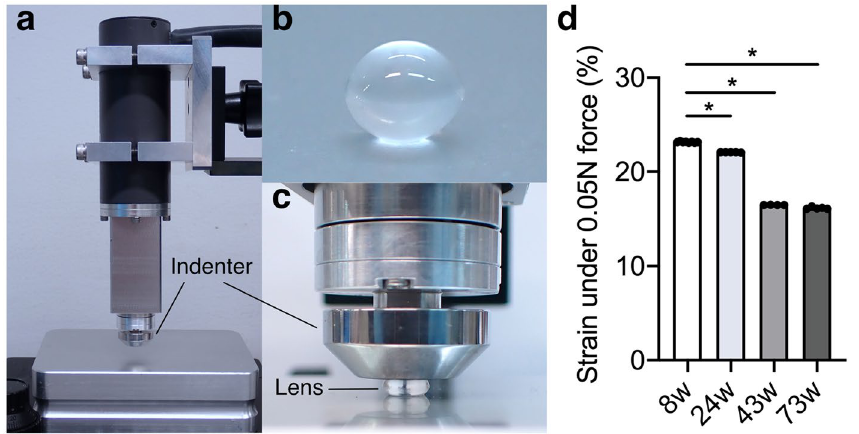
Figure 1. The measuring instrument, rat lens sample and the elasticity of young, middle and aged rat lenses. ( a ) The force–displacement measuring instrument with flat indentation. ( b , c ) The rat lens sample were put on a stage and a 12 mm-diameter flat indenter applied a load on the lens along the anteroposterior axis of the lens from above to measure the force and indentation displacement until 5.0 N (N) with the speed of 0.1 mm/s. ( d ) The lenses extracted from young (8-week-old, n = 8), middle-aged (24-week-old and 43-week-old) and old-aged (73-week-old, n = 5) male rats were assessed. The percentages of strain for the four age groups when lenses were pushed with 0.05 newtons (N) of force are shown in the bar graph. Data are presented as mean ± SEM. The asterisk indicates a statistically significant difference compared to 8-week-old (* P < 0.05, one-way analysis of variance followed by Tukey’s post-hoc test).